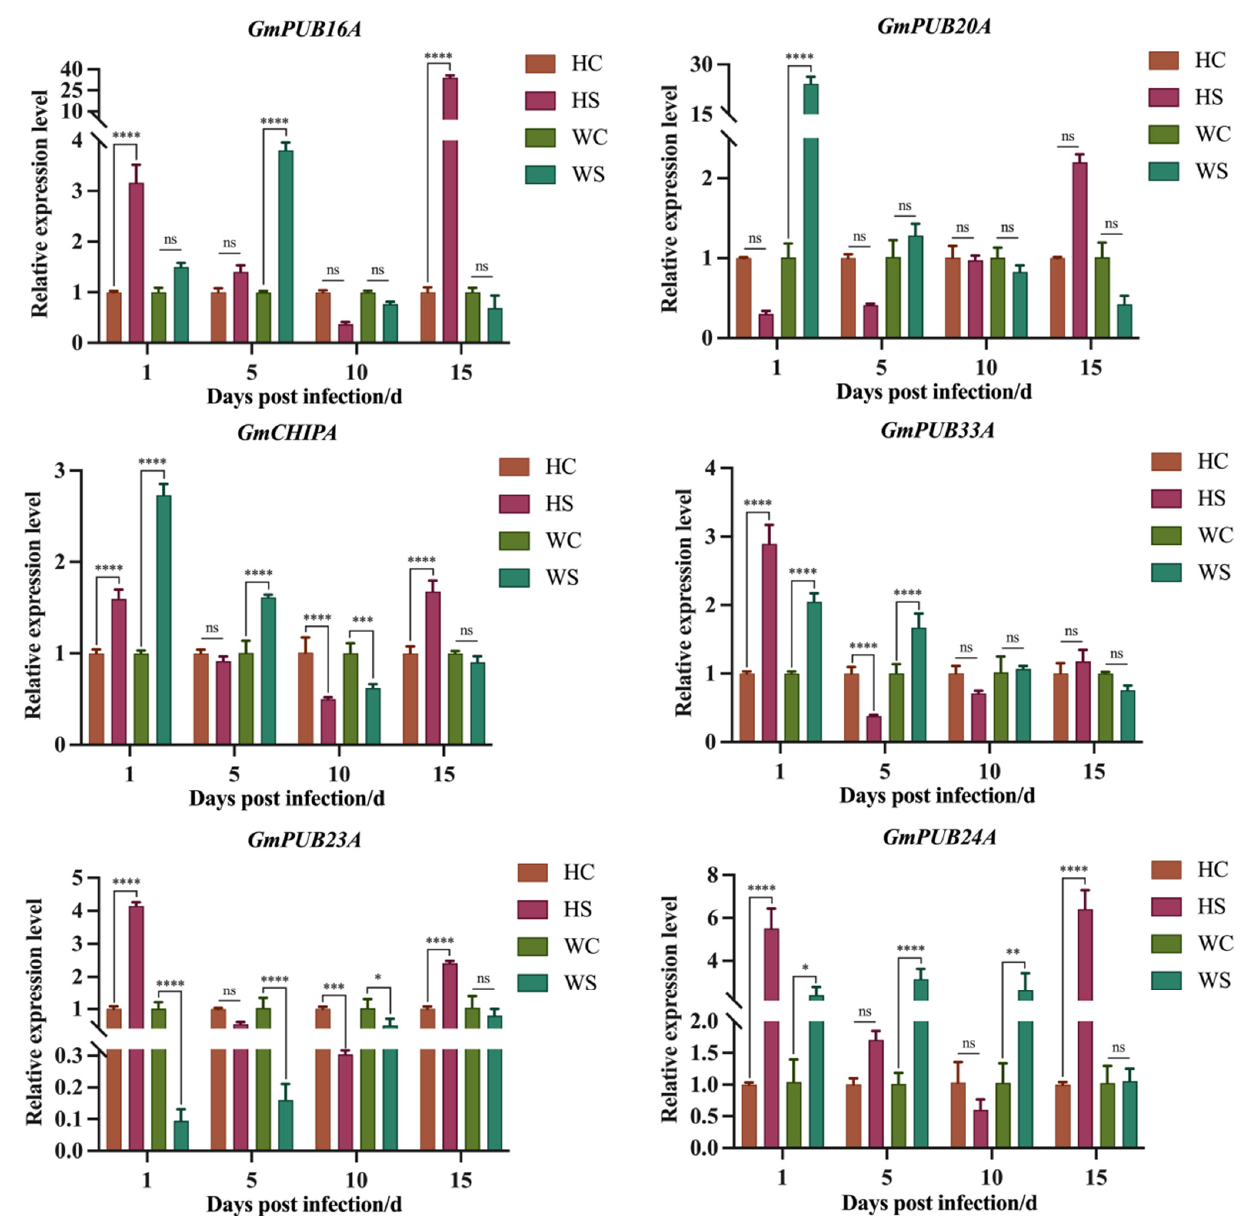
Figure 4. The response of the six GmPUBs of susceptible cultivar Williams 82 and resistant cultivar HPZ during soybean cyst nematode infection. Note: control: HC and WC represent the relative expressions of GmPUBs without soybean cyst nematode infect, respectively. Treatment: HS and WS represent the relative expressions of GmPUBs during soybean cyst nematode infect, respectively. The statistical comparisons were conducted with the t -test for members of treatment and control. ns represent not significant. *, **, *** and **** indicate significant difference at the p < 0.05, p < 0.01, p < 0.001 and p < 0.0001 probability levels, respectively.